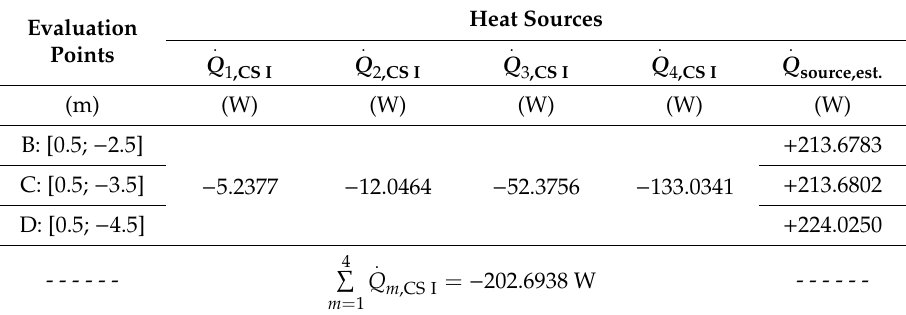
Table 4. The case study I: Reference values of the negative heat sources of the positive heat source